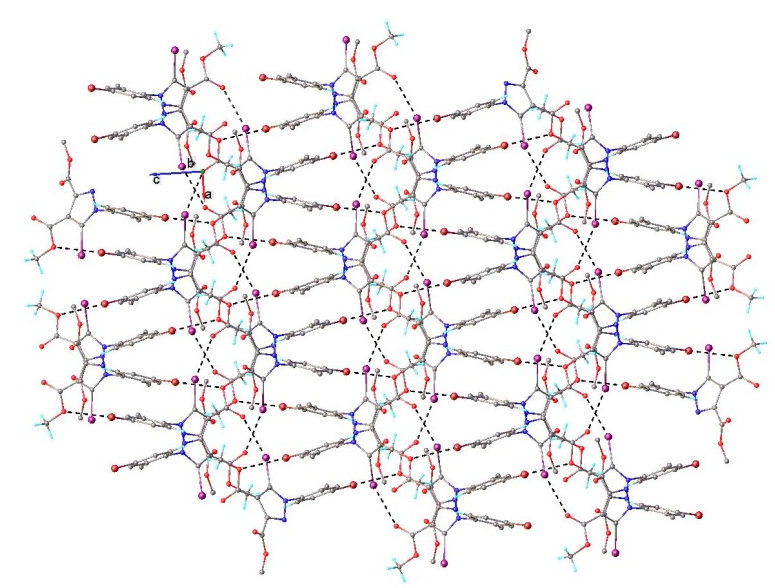
Figure 8. Packing diagram showing the formation of 3D supramolecular architecture in compound 3 . H-bond parameters: C7-H···O4 [C7-H 0.96 Å, H···O4(0.5 + x, y, 1.5 − z) 2.74 Å, C7···O4 3.62(1) Å, ∠ C7HO4 152.5°; C3-H···O3 [C3-H 0.93 Å, H···O3(0.5 − x, y − 0.5, z) 2.56 Å, C3···O3 3.34(1) Å, ∠ C3HO3 142.1°; C14-H···O3 [C14-H 0.96 Å, H···O3(1 − x, 2 − y, 1 − z) 2.57 Å, C14···O3 3.312(8) Å, ∠ C14HO3